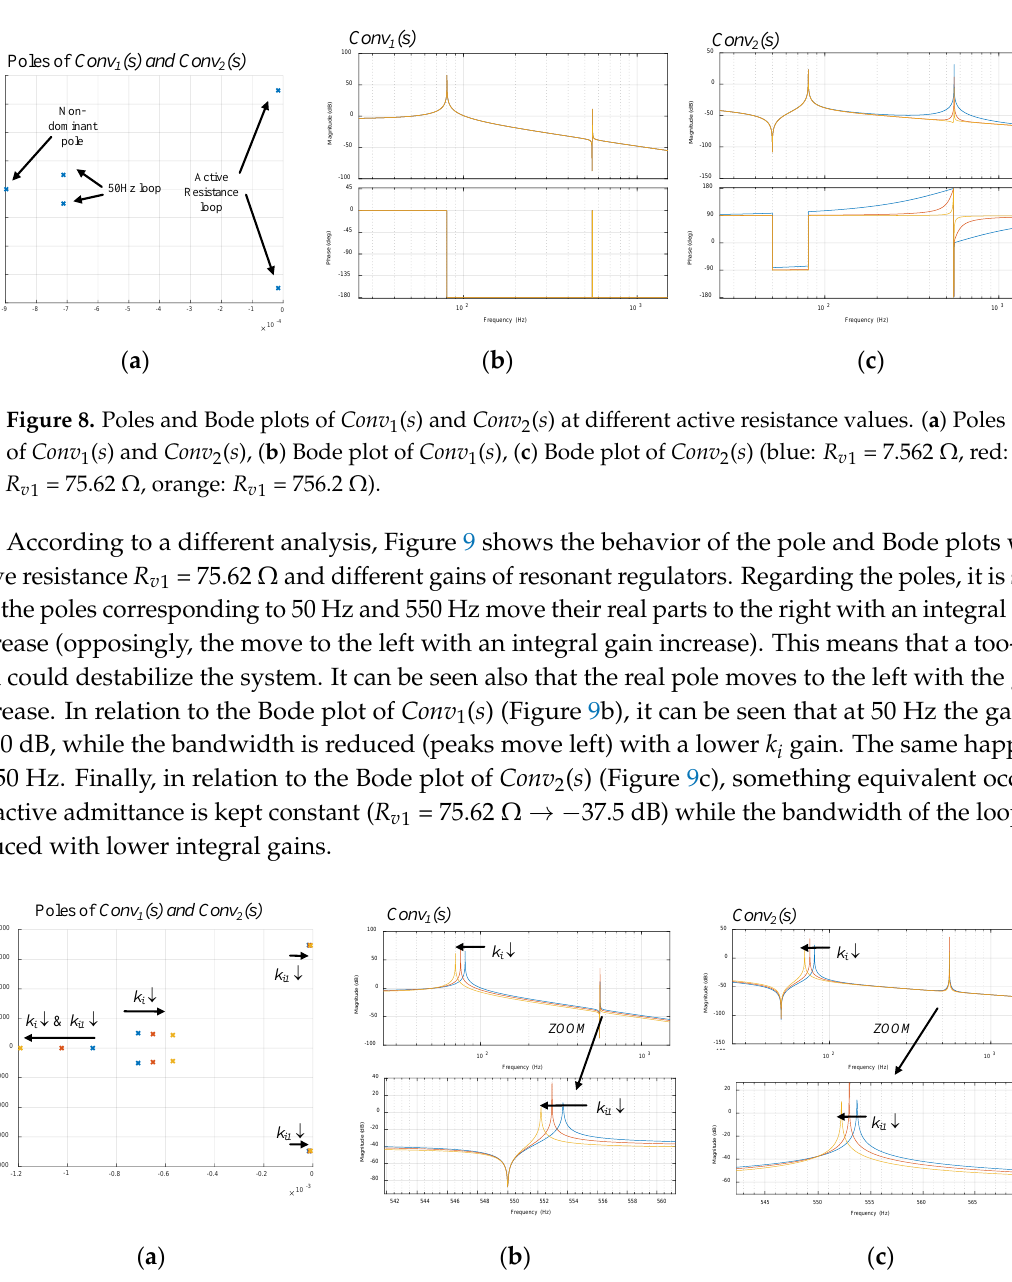
Figure 9. Poles and Bode plots of Conv 1 ( s ) and Conv 2 ( s ) with active resistance R v 1 = 75.62 Ω and different gains of resonant regulators. ( a ) Poles of Conv 1 ( s ) and Conv 2 ( s ), ( b ) Bode plot of Conv 1 ( s ), ( c ) Bode plot of Conv 2 ( s ) (blue: k i = k i 1 = 40,837, red: k i = k i 1 = 32,670, orange: k i = k i 1 = 24,502).